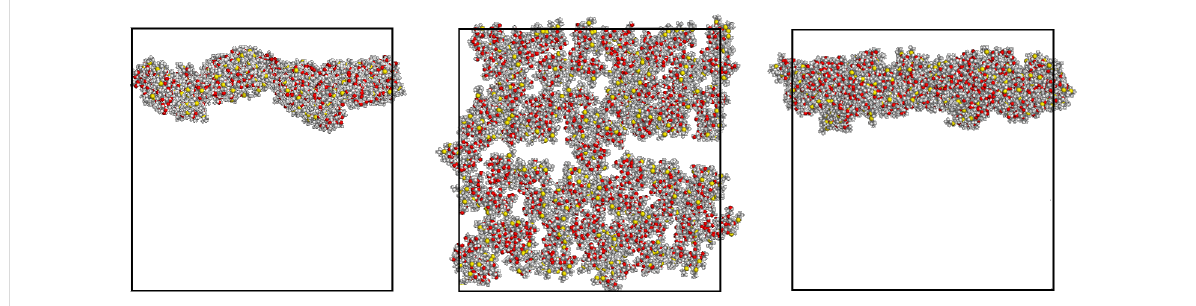
Figure 6: The second final arrangement of sixty-four molecules within the large periodic cell of 123.0 Å after an MD run of 50 ns viewed along the z -, y -, x -directions (from left to right). The flat membrane with a minor central gap is clearly seen in the central panel.